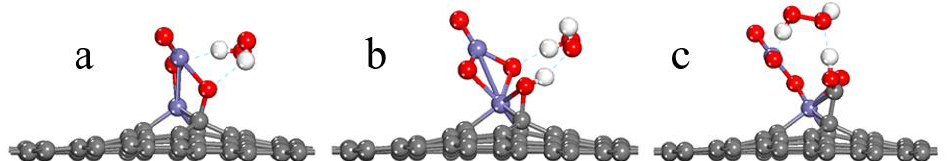
Figure 5. Stable configuration of H 2 O 2 adsorption on ( a ) Fe 2 O 3 /G def , ( b ) Fe 2 O 3 /HyG, and ( c ) Fe 2 O 3 /CyG. The C atom is gray, the O atom is red, the Fe atom is purple, and the H atom is white.